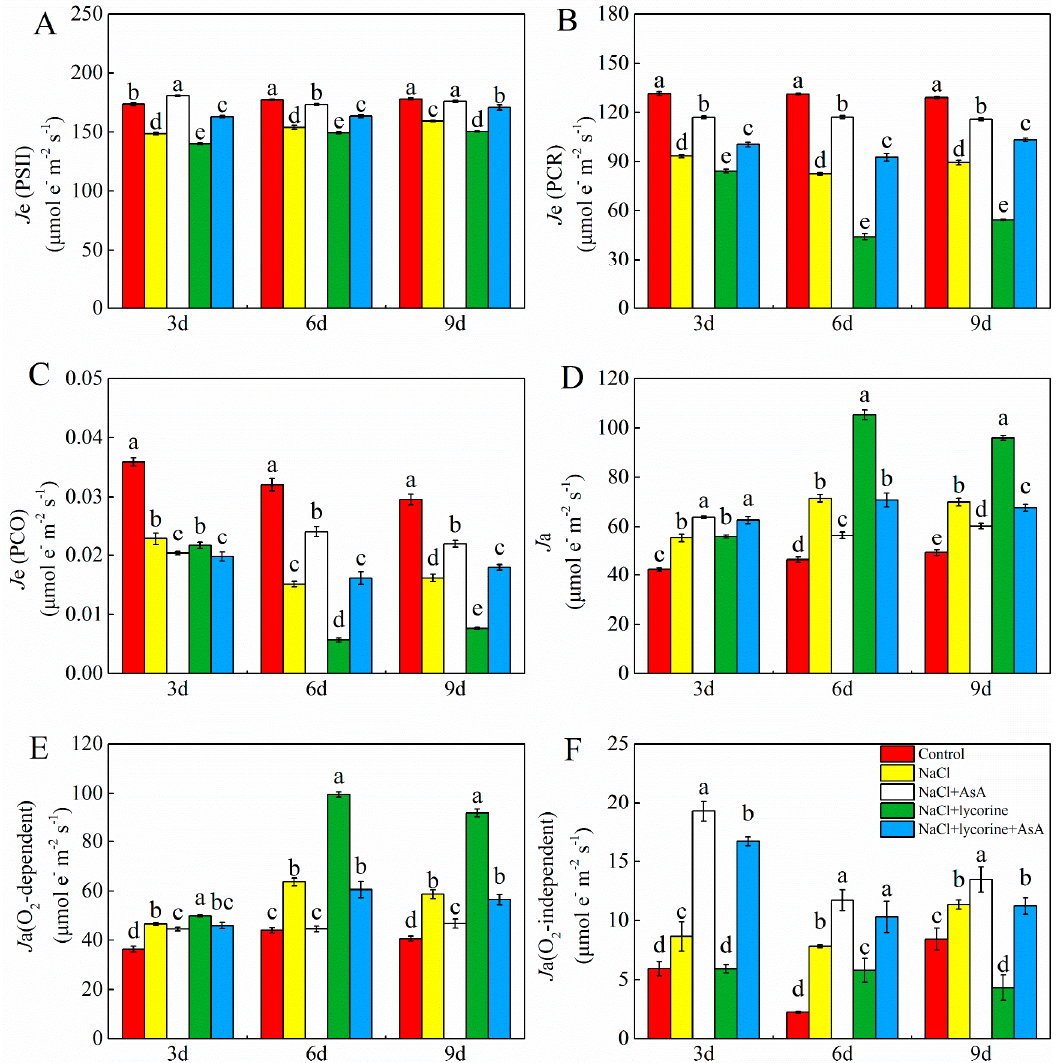
Figure 4. Values of the rate of electron transport through PSII J e(PSII) ( A ), electron flux for the photosynthetic carbon reduction cycle ( J e(PCR)) ( B ), electron flux for photorespiration ( J e(PCO)) ( C ), alternative electron flux ( J a) ( D ), the O 2 -dependent alternative electron flux ( J a(O 2 -dependent)) ( E ), and the O 2 -independent alternative electron flux ( J a(O 2 -independent)) ( F ) in leaves of salt-stressed tomato seedlings with or without exogenous reduced ascorbic acid (AsA) and lycorine (AsA synthesis inhibitor) spraying. Abbreviations 3d, 6d, and 9d represent the third, sixth, and ninth day after treatment, respectively. Control, no added NaCl and sprayed with distilled water; NaCl, added 100 mmol·L –1 NaCl and sprayed with distilled water; NaCl + AsA, added 100 mmol·L –1 NaCl and sprayed with 0.5 mmol·L –1 AsA; NaCl + lycorine, added 100 mmol·L –1 NaCl and sprayed with 0.25 mmol·L –1 lycorine; NaCl + lycorine + AsA, added 100 mmol·L –1 NaCl and sprayed with 0.25 mmol·L –1 lycorine plus 0.5 mmol·L –1 AsA. Values are means ± SD ( n = 3). Values with a different letter within a sampling date are significantly different ( p < 0.05).